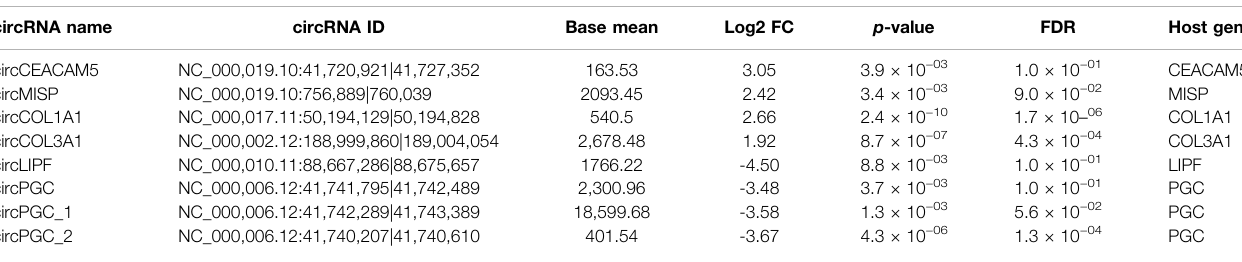
TABLE 3 | Top 8 (4 upregulated and 4 downregulated)